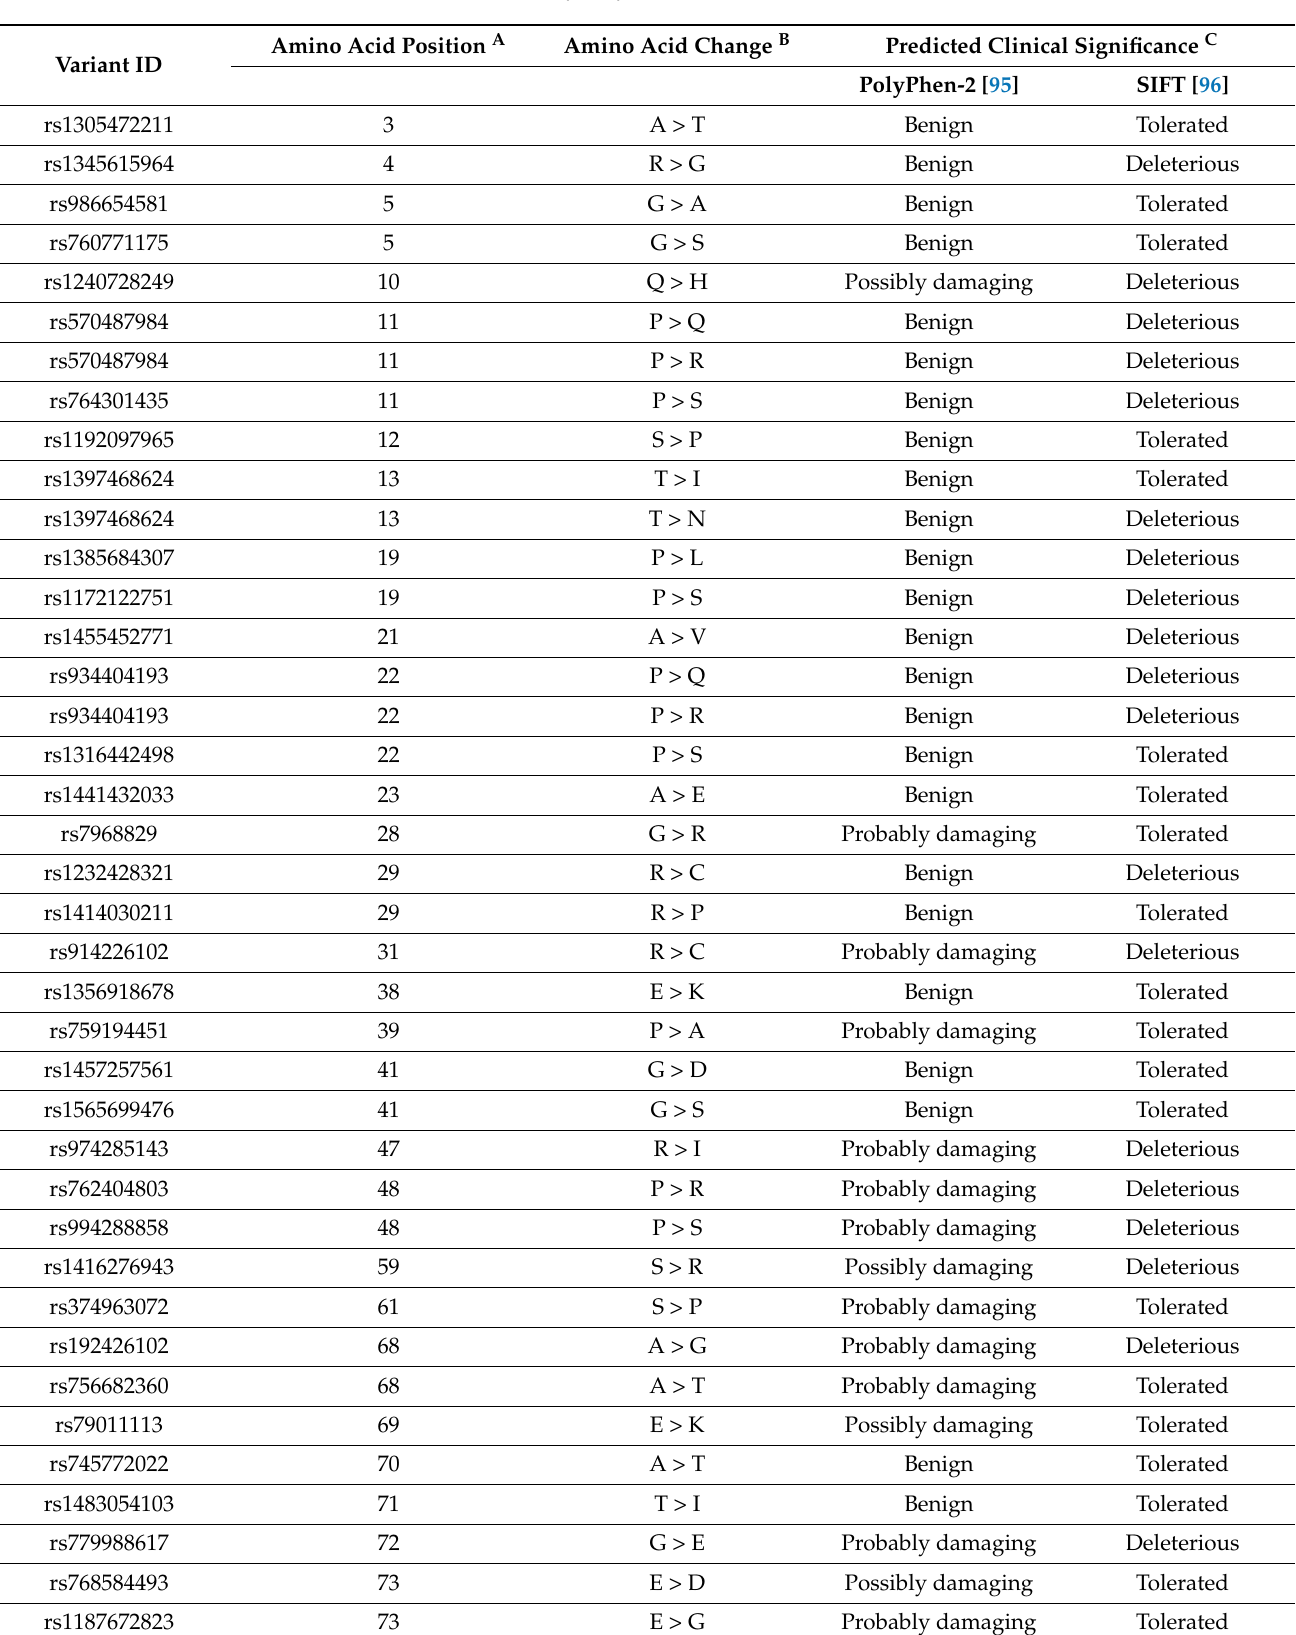
Table 1. HMGA2 missense variants [94] with predicted consequence and clinical significance of amino acid substitution by PolyPhen-2 [95] and SIFT